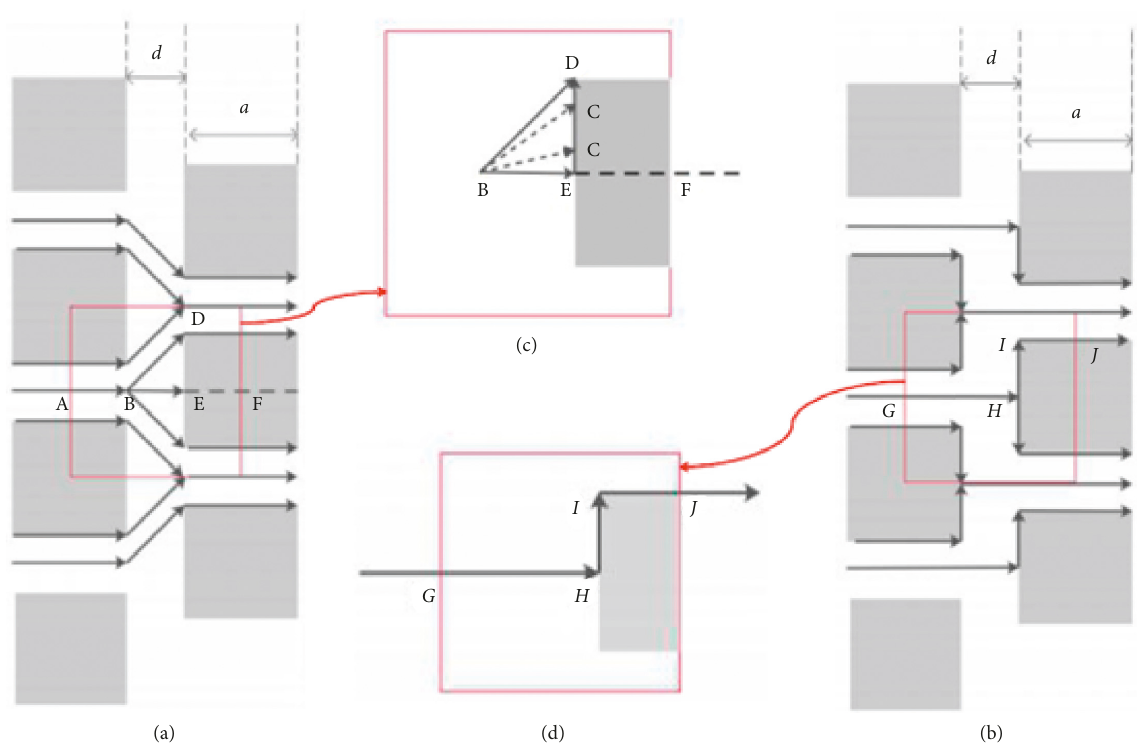
Figure 2: Two idealized scenarios of streamlines for creeping flow in porous